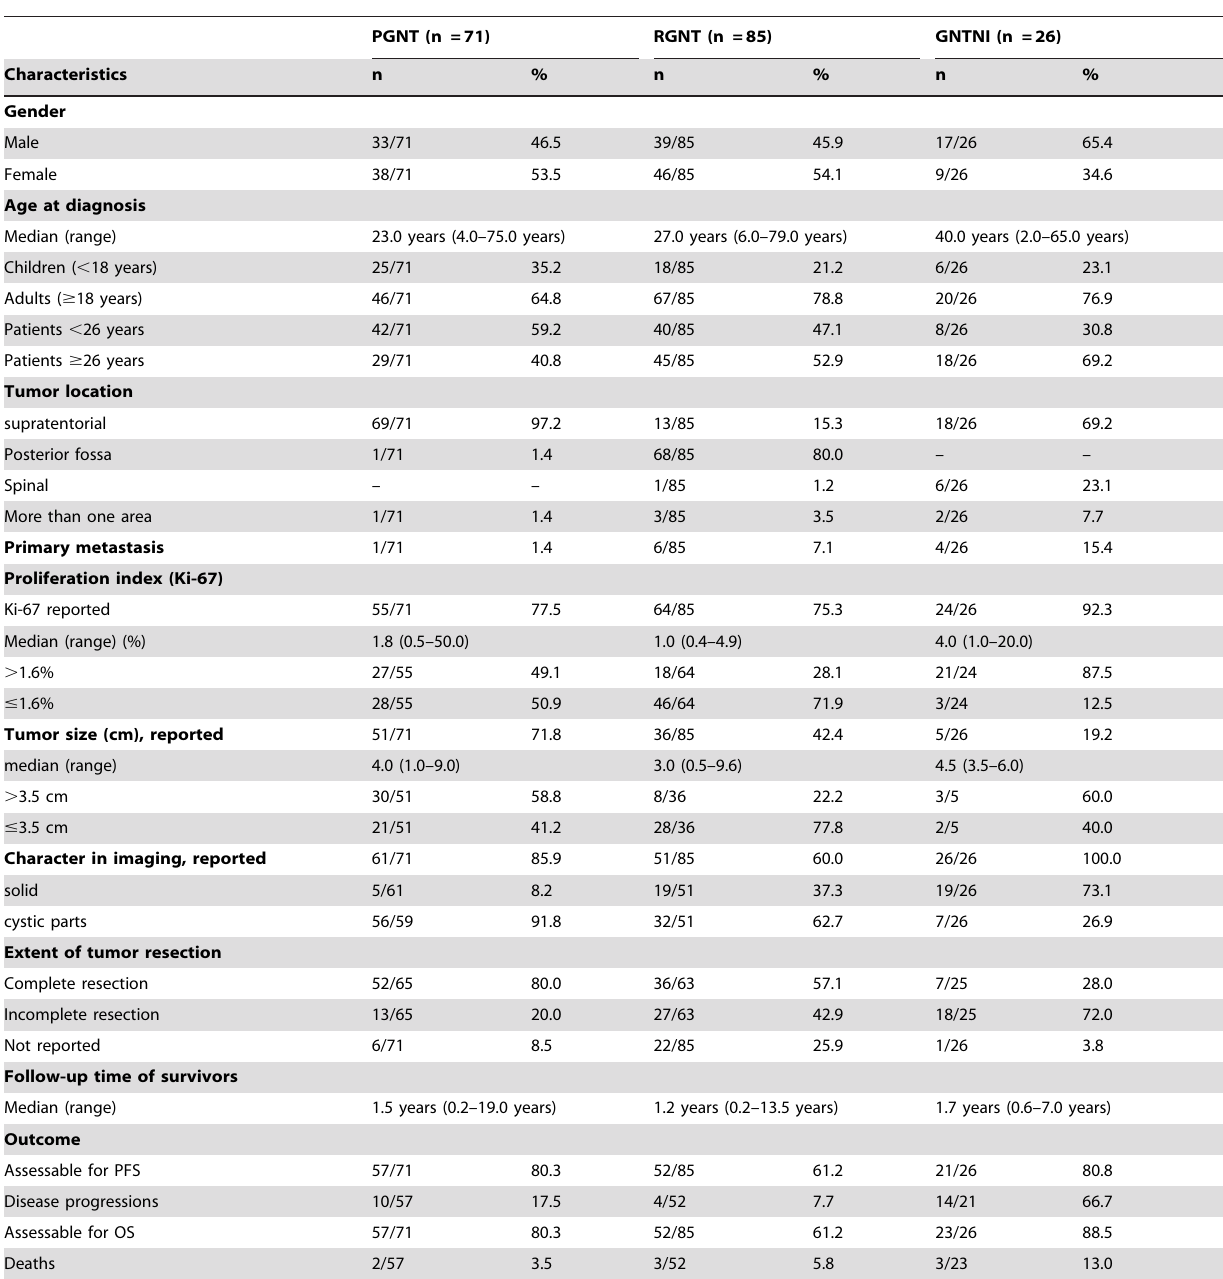
Table 2. Clinical Characteristics of